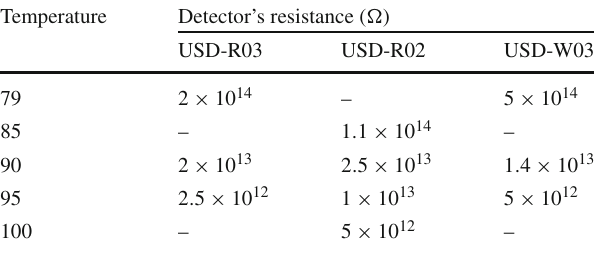
Table 1 The calculated values of the resistance from the I-V curves for three USD fabricated